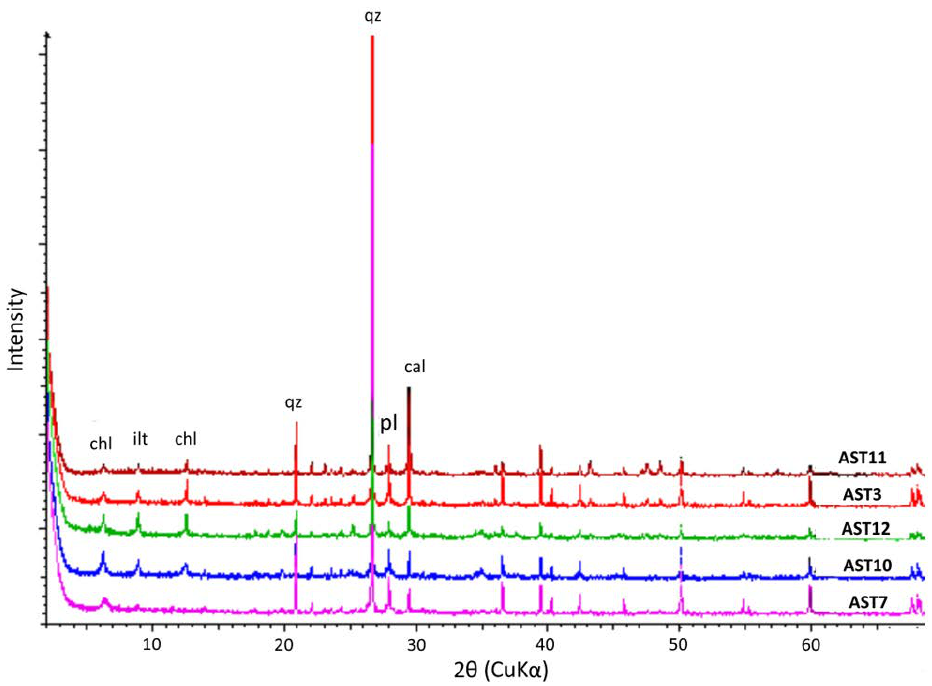
Figure 9. Representative X-ray powder diffractograms of sandstones.Mineral abbreviations are according to [44]: calcite (cal); chlorite (chl); plagioclase (pl); illite (ilt); quartz (qz). Table 3. The mineralogy of the samples as resulted from the evaluation of the X-ray powder diffrac- tograms. Mineral abbreviations are according to [44]: alkali-feldspars (afs); aragonite (arg); calcite